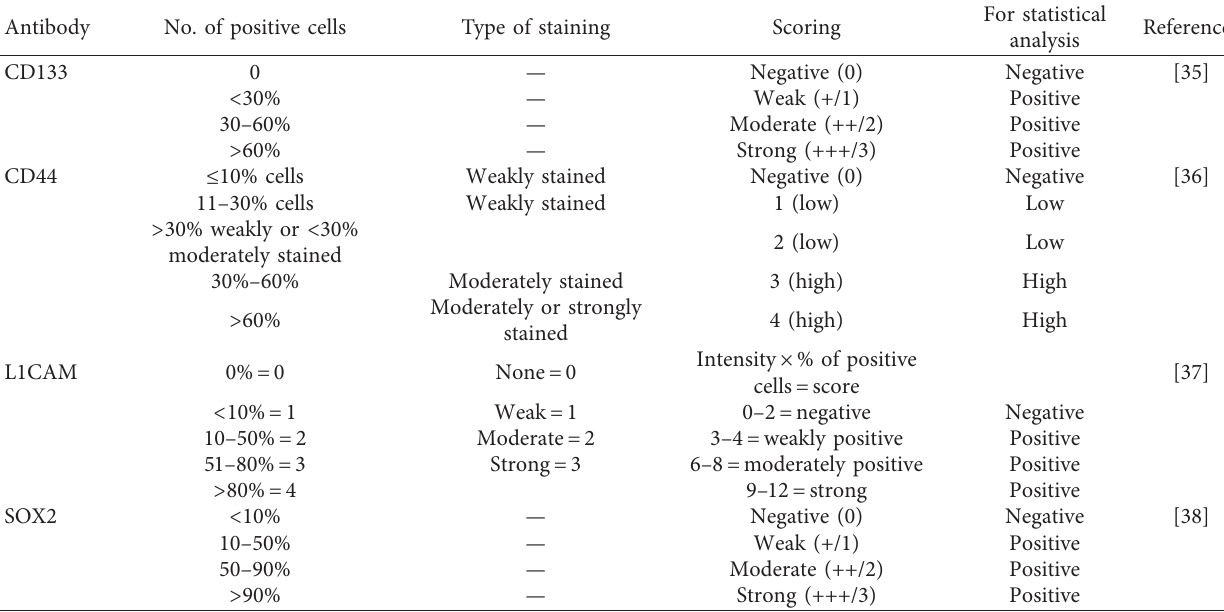
Table 2: Immunoreactivity scoring criteria for all antibodies.